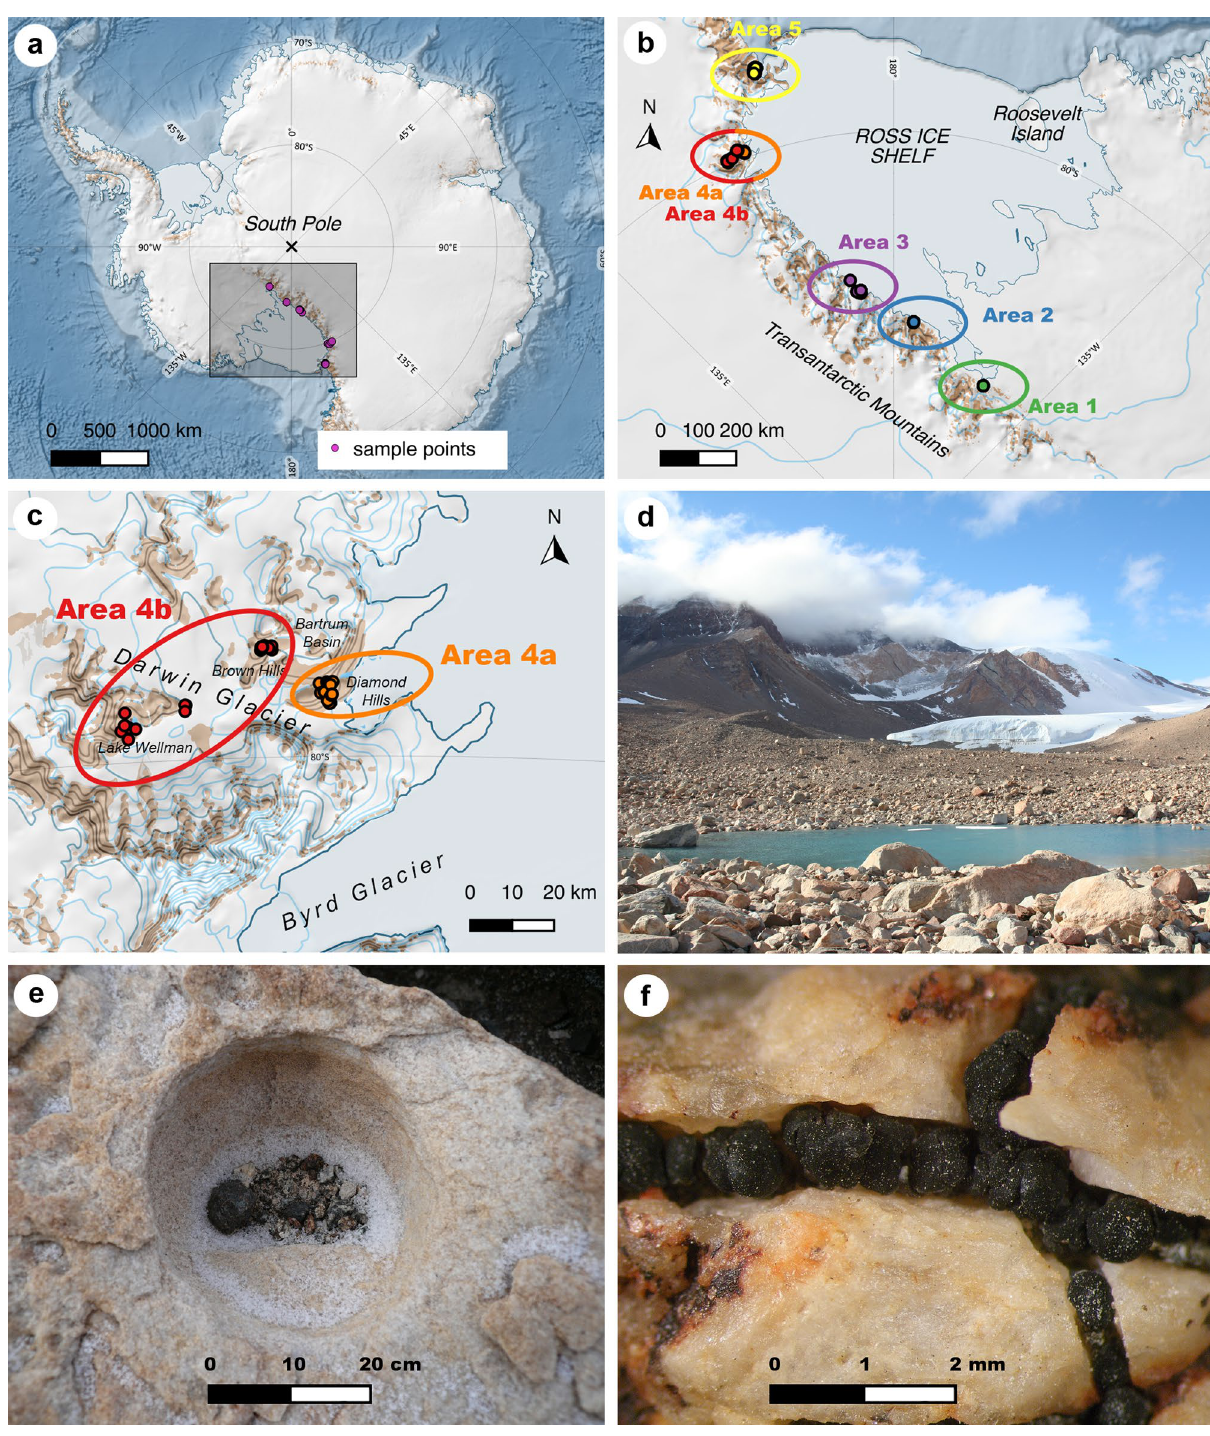
Figure 1. Location of the sample points and lichen habitats. ( a ) Antarctic continent, investigated area marked with rectangle, ( b ) location of the six different areas defined in the study, ( c ) differentiation of area 4 in subareas 4a and 4b, ( d ) Batrum Basin, ( e ) microhabitat with crustose lichens at Lake Wellman, ( f ) chasmolithic growth of Lecidea cancriformis . Maps of ( a ), ( b ) and ( c ) were created with QGIS 3.12 (http:// www. qgis. org/) and are based on the dataset Quantarctica 18